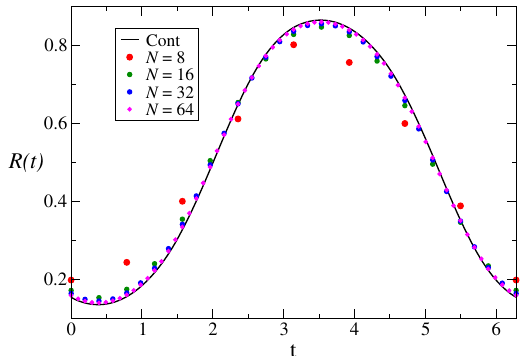
FIG. 6. Comparison between the periodic steady state obtained with the continuous deterministic protocol from Eq. (A1) and the steady state obtained with the stochastic protocol that jumps with a rate γ ¼ L= τ . For the second case, the horizontal axis is t ¼ nT=L . For the periodic steady state, we plot R PS ð t Þ , and for the steady state, we plot the conditional probability P ð u j n Þ for different values of L . The parameters are set to ω ¼ 1 and E 1 0 ¼